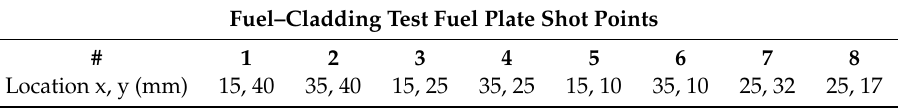
Figure 5. Example of fuel–cladding test fuel plate with locations for shock test indicated. Table 2. Example of fuel–cladding test fuel plate shock location.